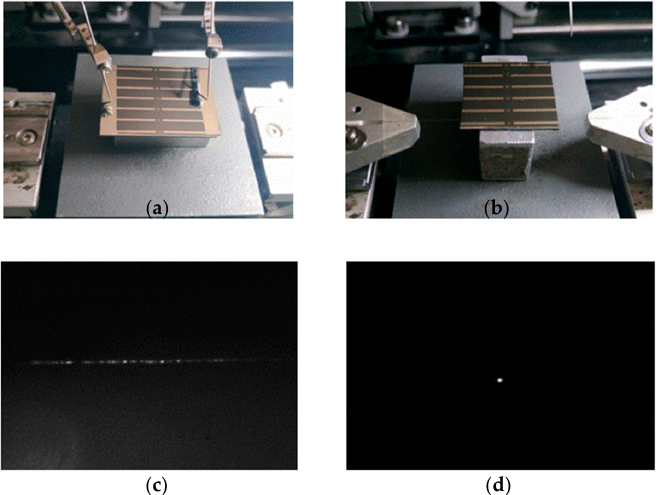
Figure 3. ( a ) Measuring process of applying electric power; ( b ); the testing photo of the TO switch with electric power applied; ( c ) Relative output patterns before power applied and ( d ) output patterns after the electric power